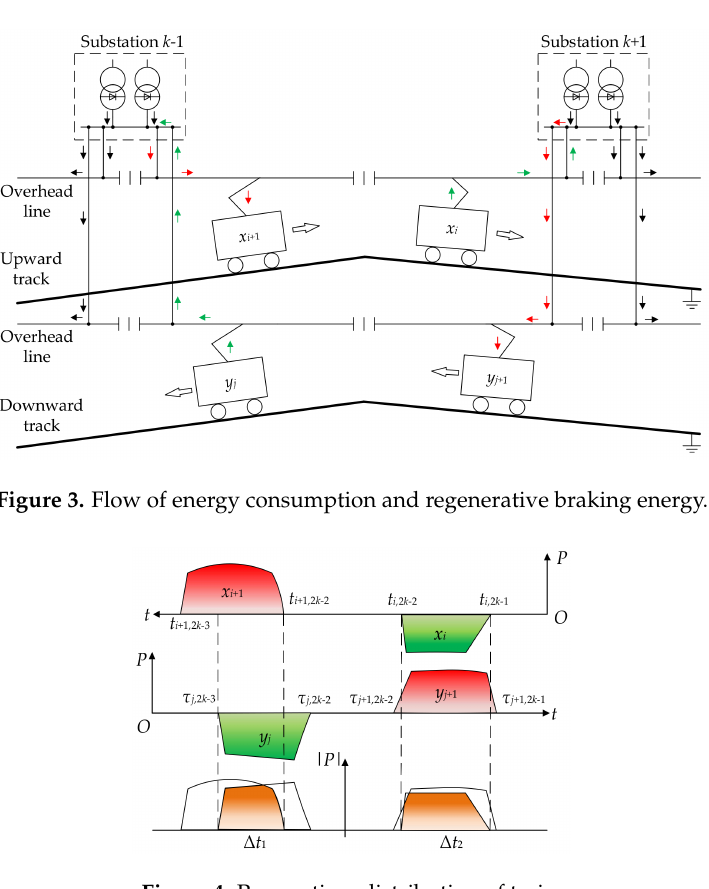
Figure 4. Power–time distribution of train.